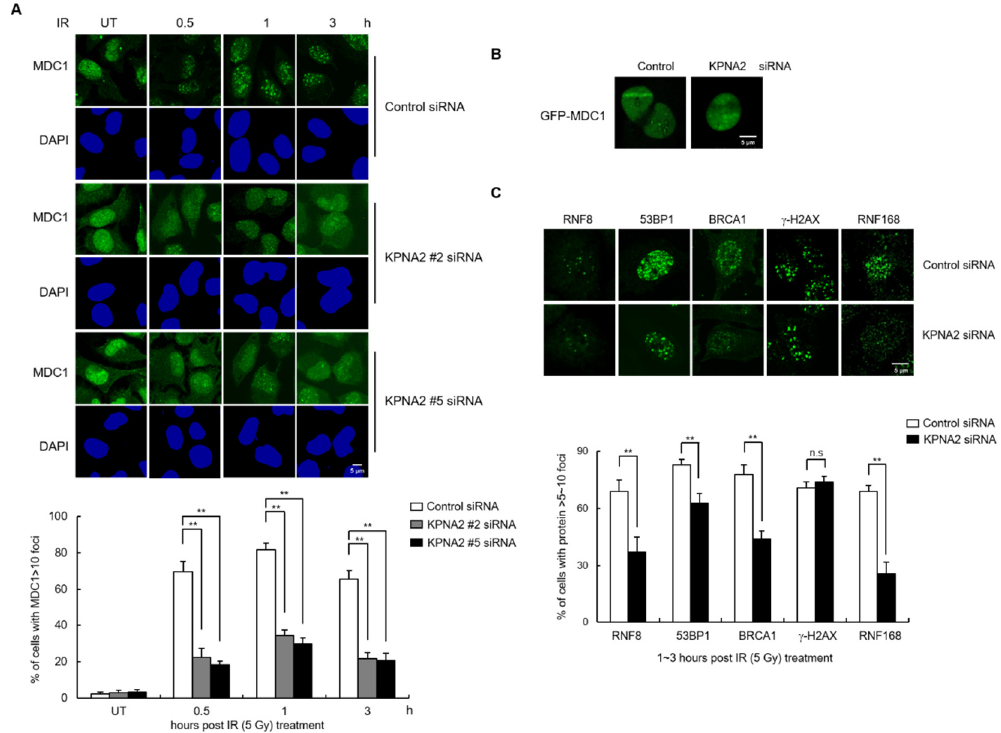
Figure 4. KPNA2 knockdown reduces IR-induced MDC1 foci formation. ( A ) Control and KPNA2-depleted HeLa cells were treated with or without exposure to 5 Gy of IR and fixed at the indicated time points. Immunostaining was performed using MDC1 antibody and Nuclei were stained DAPI (upper). The percent of cells containing > 10 nuclear MDC1 foci was then calculated (lower). Scale bar, 5 µ m. ( B ) Control and KPNA2-depleted cells were transfected with GFP-KPNA2 and laser-microirradiated using 405 UV laser. The representative images were shown after laser-microirradiation. Scale bar; 5 µ m. ( C ) Control or KPNA2-depleted HeLa cells were exposed to 5 Gy of IR for 1~3 h and immunostained with indicated antibodies. The representative images (upper) and percentage (lower) of cells containing > 5–10 nuclear RNF8, 53BP1, BRCA1, RNF168, or γ -H2AX foci were shown. Scale bar; 5 µ m. Data are presented as means ± s.d. P value are based on two-tailed Student’s t -test: ** p < 0.01 ns, not significant.